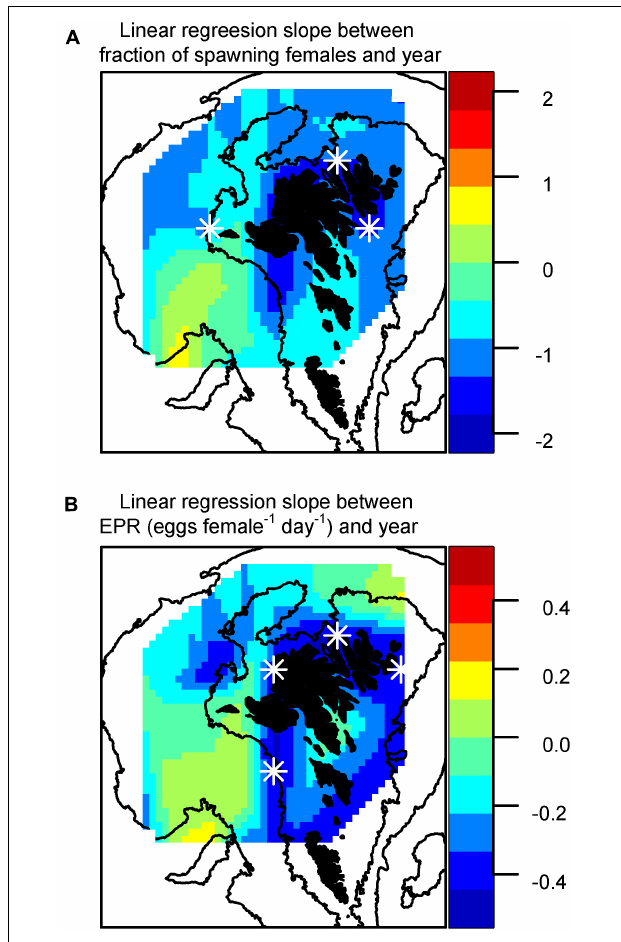
FIGURE 7 | Individual egg production rates (eggs females − 1 day − 1 ) on the inner shelf in late April vs. (A) temperature at station O (open circles indicate bloom years) and (B) chlorophyll at station S 1997–2020. Vertical lines indicate standard